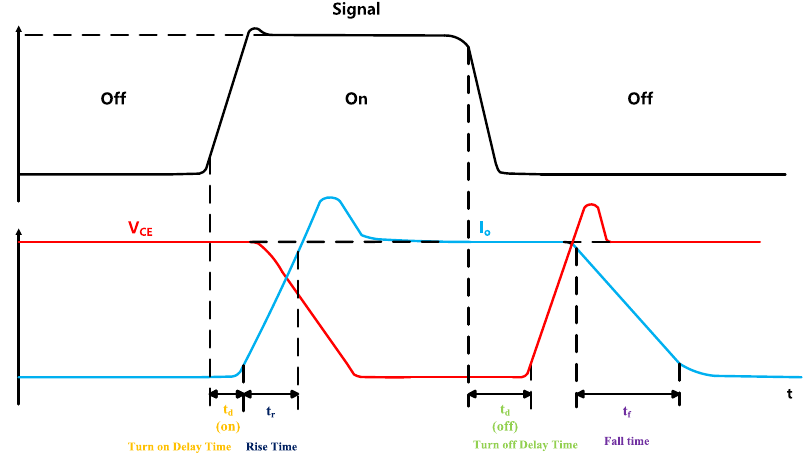
/ o ff characteristics of a switching power Figure 5. Turn-on/off characteristics of a switching power device. Figure 5. Turn-on